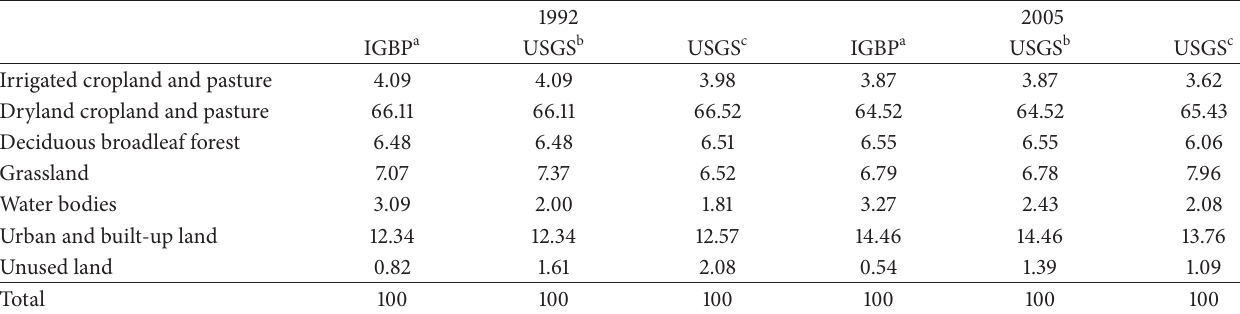
Table 4: Comparison table of area percentage (%) of each land-cover and land-use types among various kinds of classification